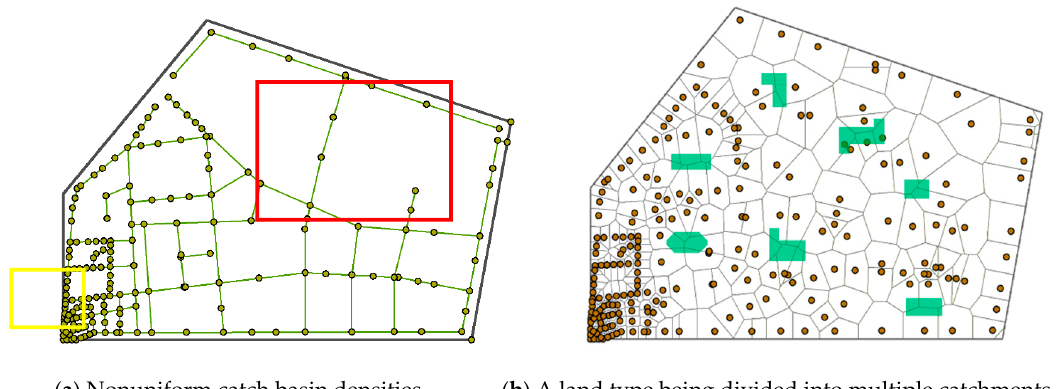
Figure 3. Limitations of the state-of-the-art method for catchment division, ( a ) denotes the limitation of the catch basin desities, ( b ) denotes the limitation of the land type consistence. (The red panel in Figure 3a denotes the situation with low density of catch basin nodes, whereas the yellow panel denotes the situation with high density of nodes).